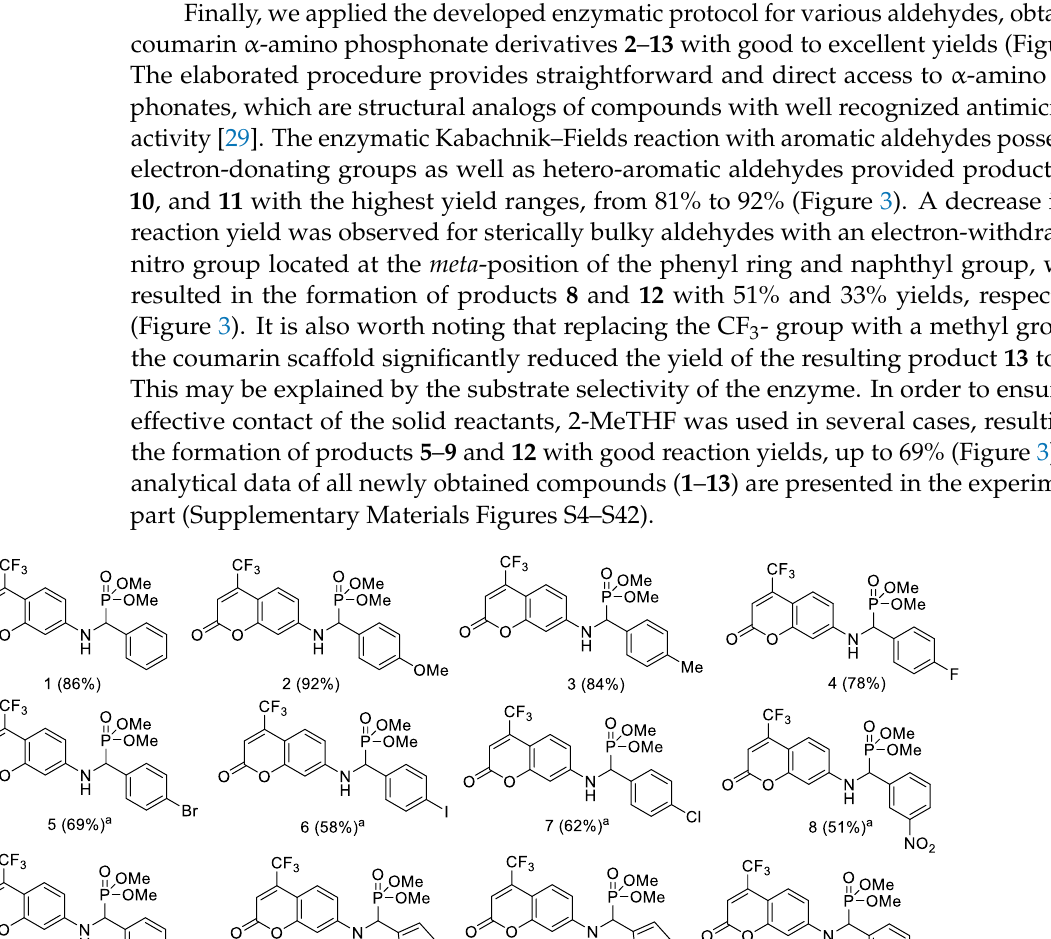
Figure 2. Reuse of the Novozym 435 catalyst.